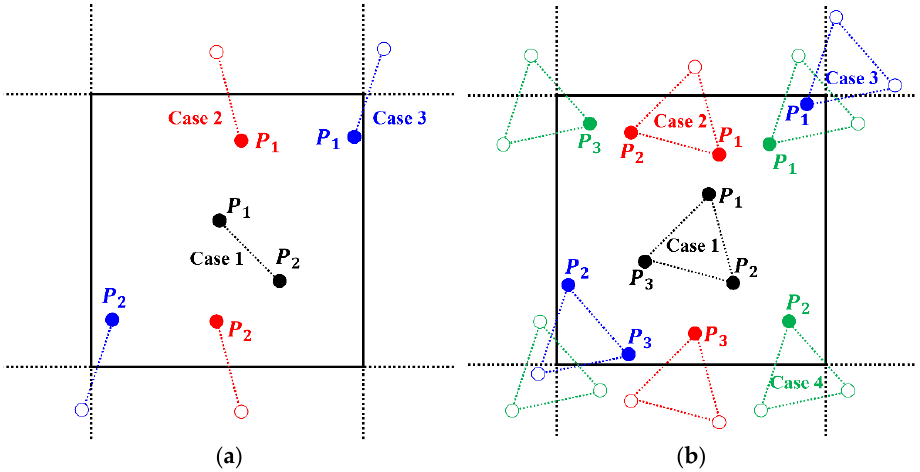
Figure 3. Illustration of periodic sampling method for 2D system: ( a ) Three cases of 2 ‐ point sam ‐ pling; ( b ) Four cases of 3 ‐ point sampling.